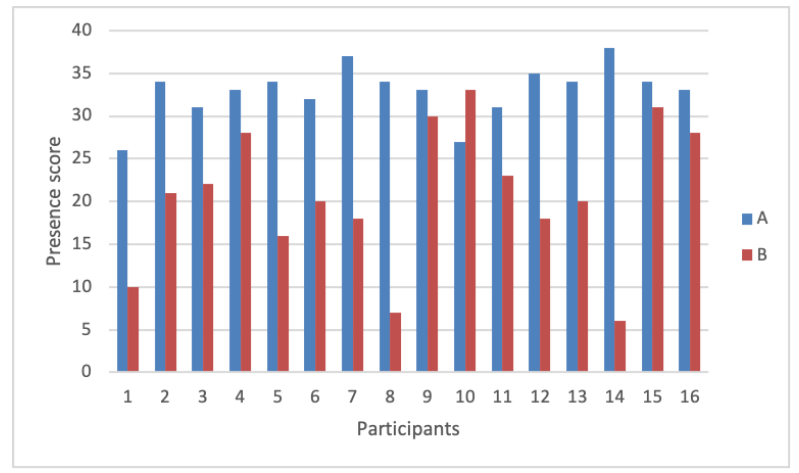
Figure 3. Presence score for 16 participants in Experiment 1.